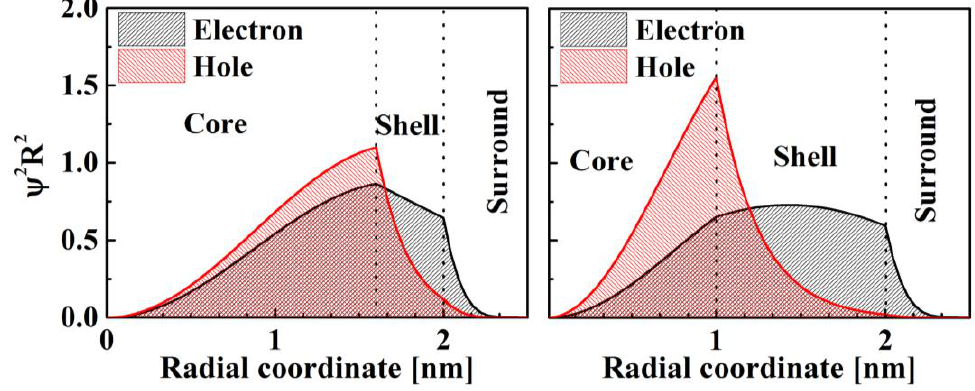
Figure 7. Probability distribution of charges in QD heterostructures with external radius R S = 2 nm and different core radii: ( a ) R C = 1.6 nm; ( b ) R C = 1.0